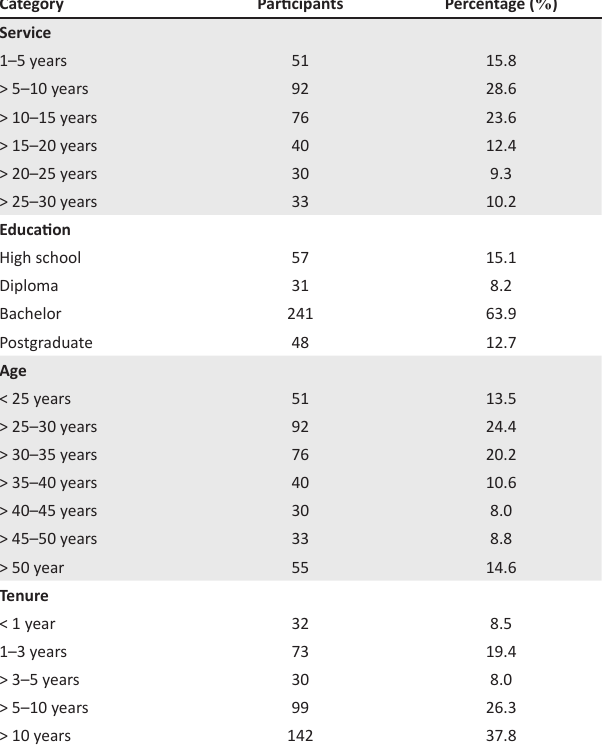
TABLE 6: Demographic